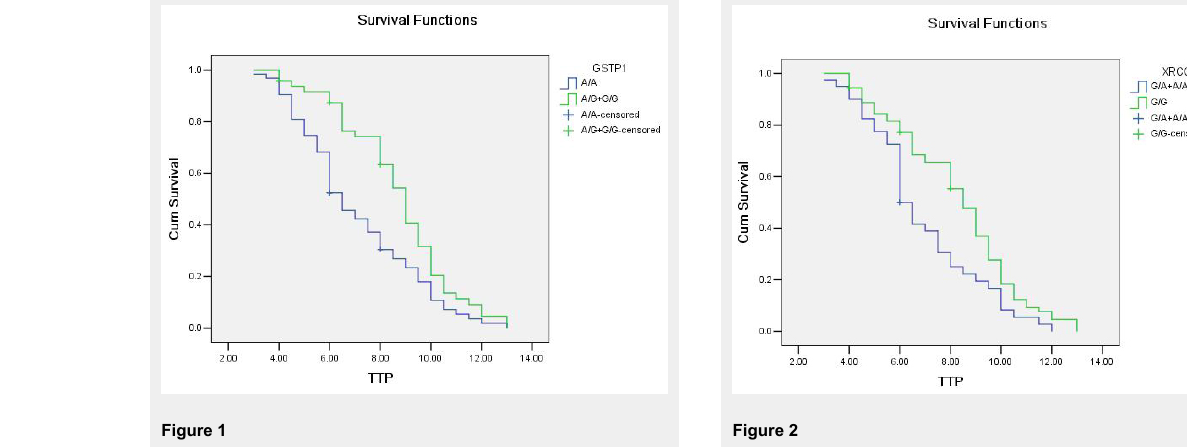
Association between XRCC1G28152A genotypes (G/A and A/A as a combined group) and time to progression (TTP) in patients with advanced NSCLC receiving platinum- based chemotherapy. The vertical hash marks denote the time of last follow up for those patients lost to follow up.